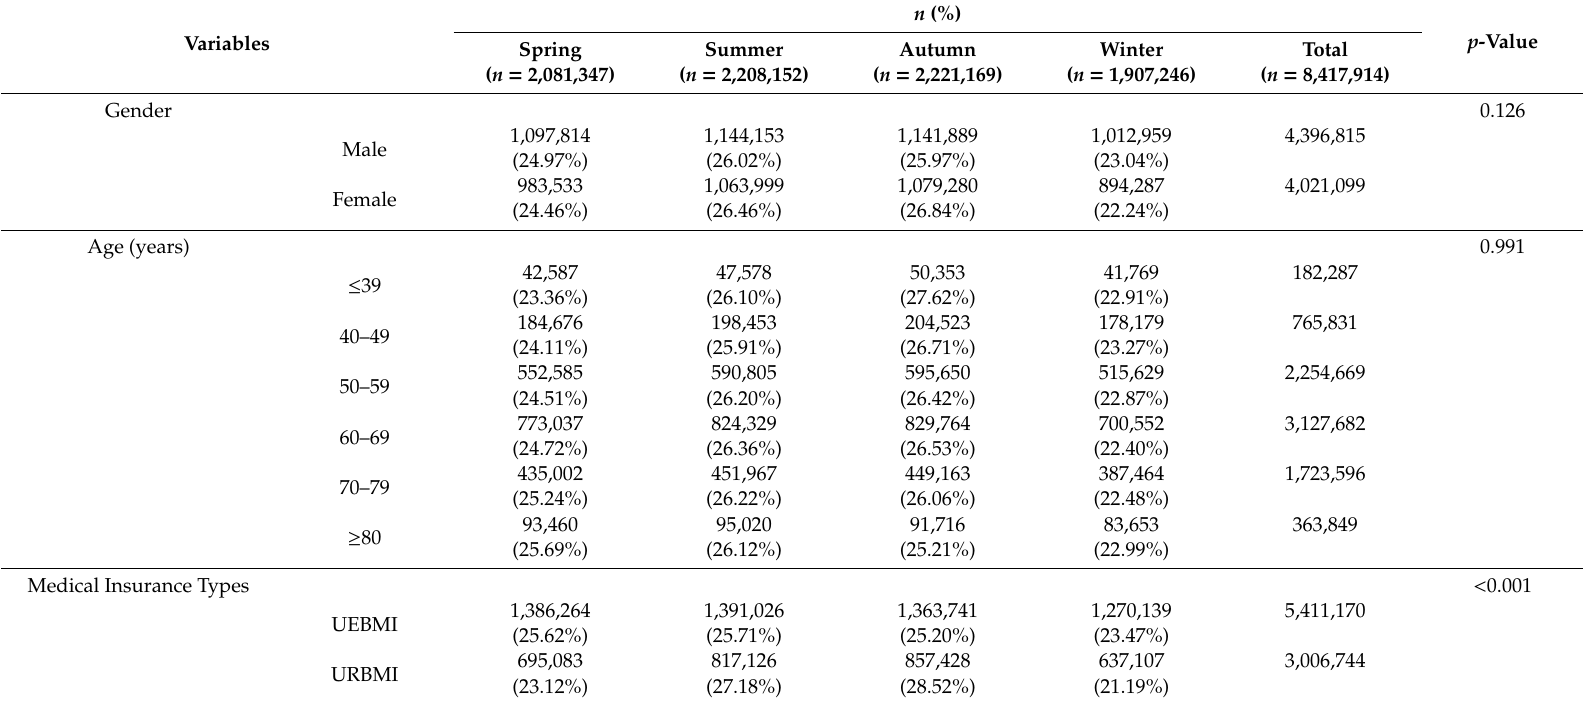
Table 1. The frequency of outpatient visits in each season from 2015 to